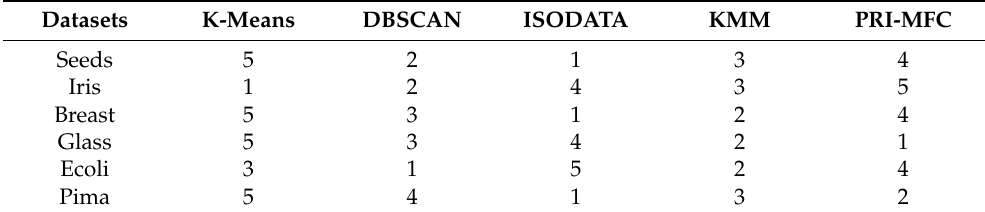
Table 6. The weight values of the ACC of five algorithms on the UCI datasets.